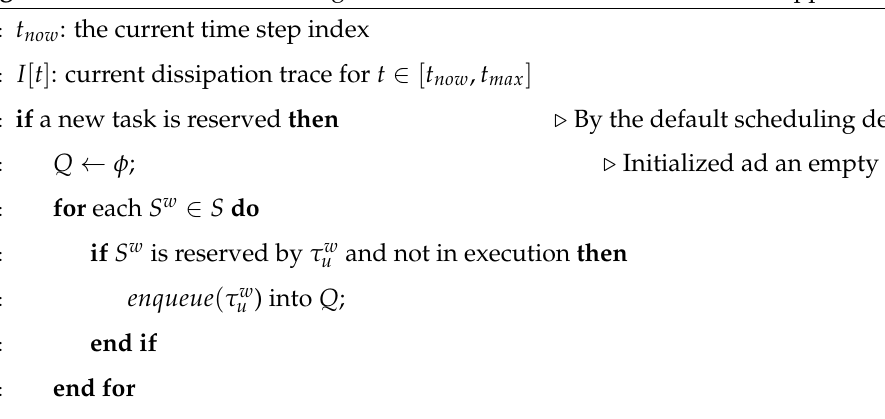
Algorithm 3 Run time scheduling of the reserved tasks in the MAX_VAR